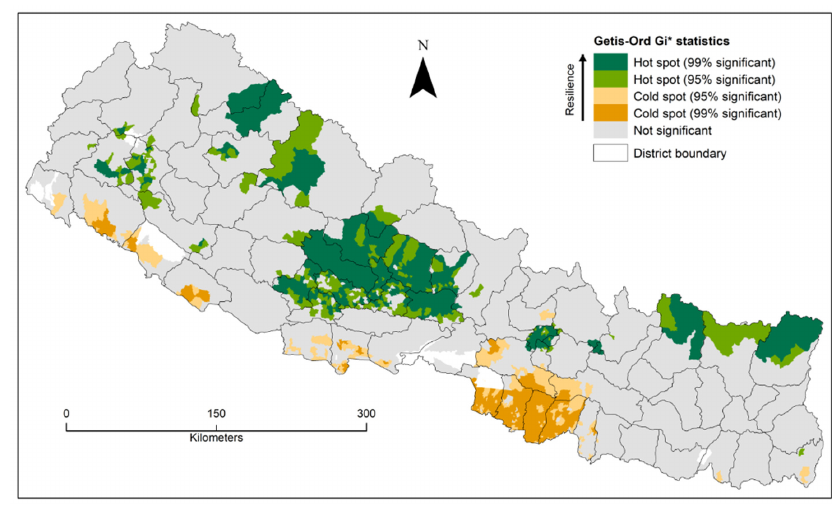
Figure 4. Spatial agglomeration of CDRI.